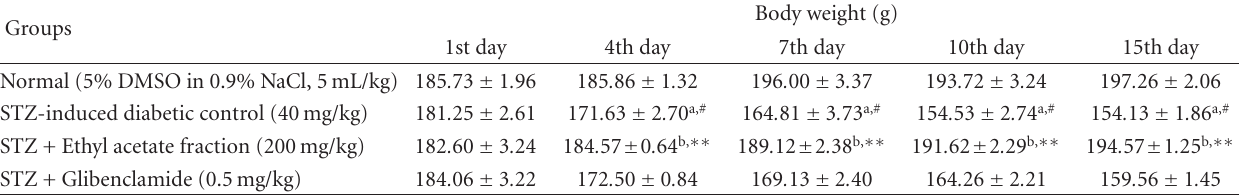
Values are mean ± SEM, 6 rats in each group, a,# P < 0 . 001 as compared to normal control